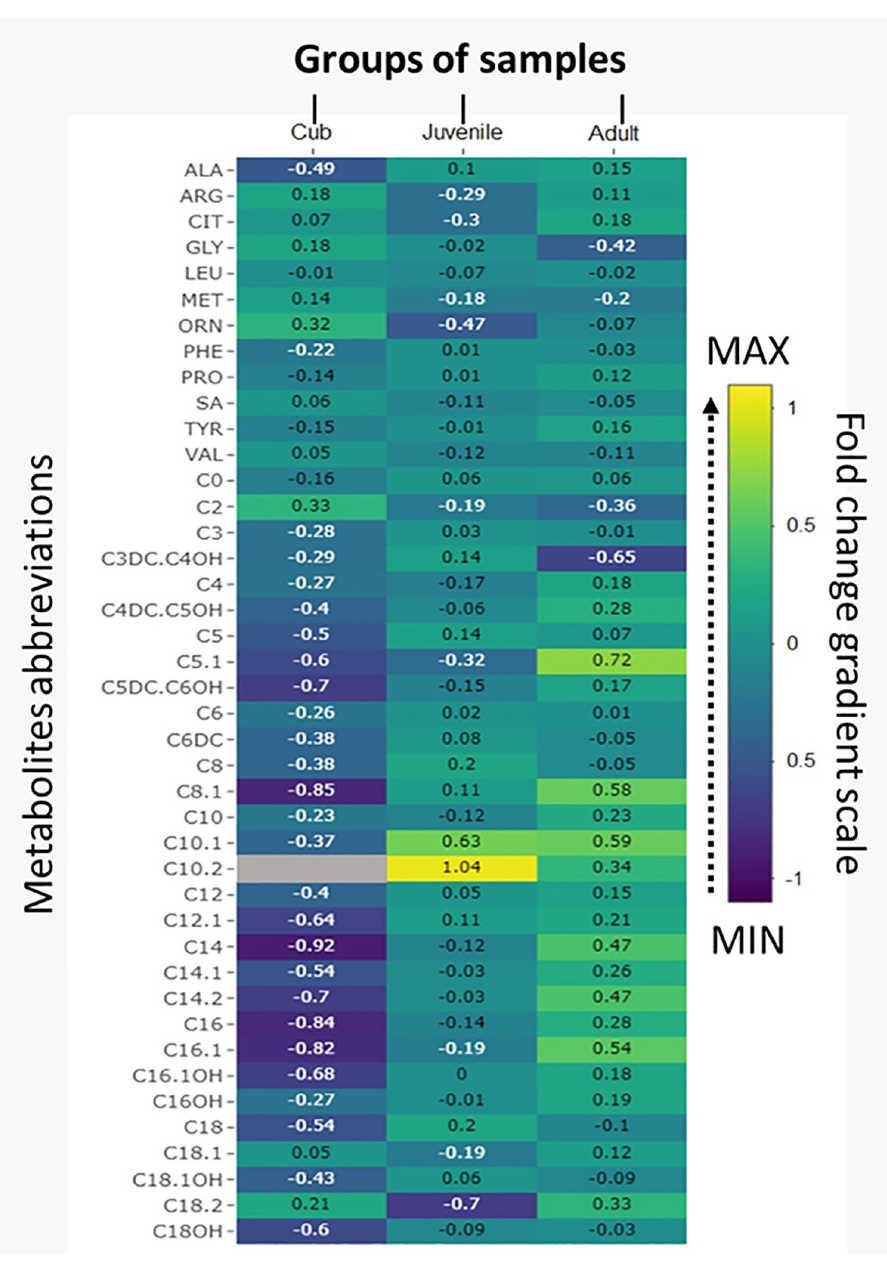
Fig 2. Heat map represents metabolites analyzed by folds in cubs (0–2 years), juveniles (3–6 years); adults ( � 7